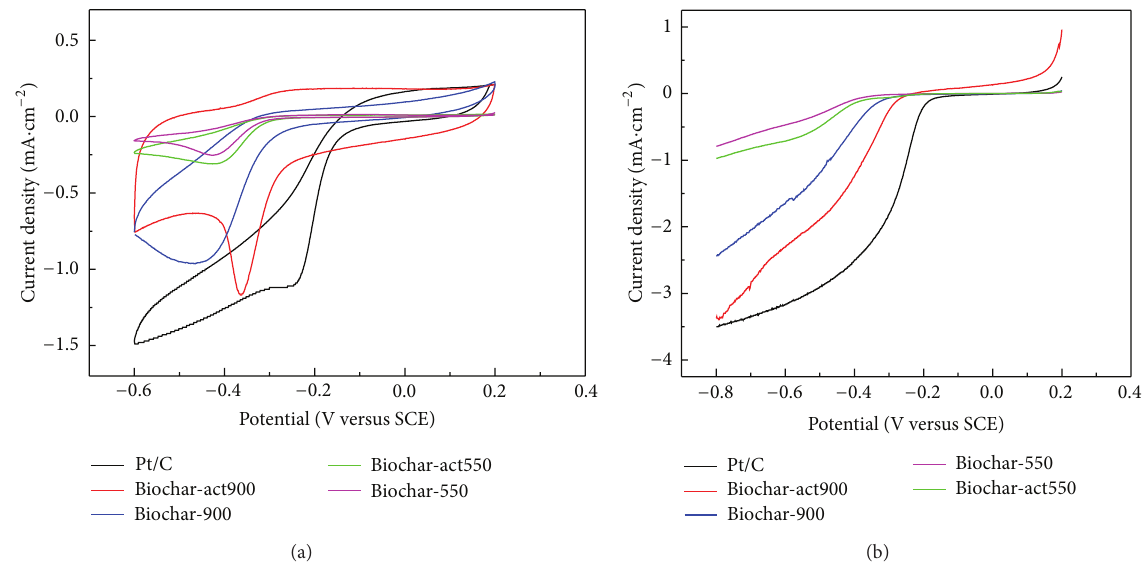
Figure 1: CV (a) and LSV (b) of various electrodes for the oxygen reduction at scan rate of 100mV/S.